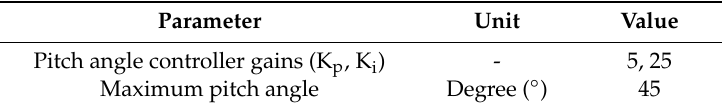
Table A3. Turbine parameters.